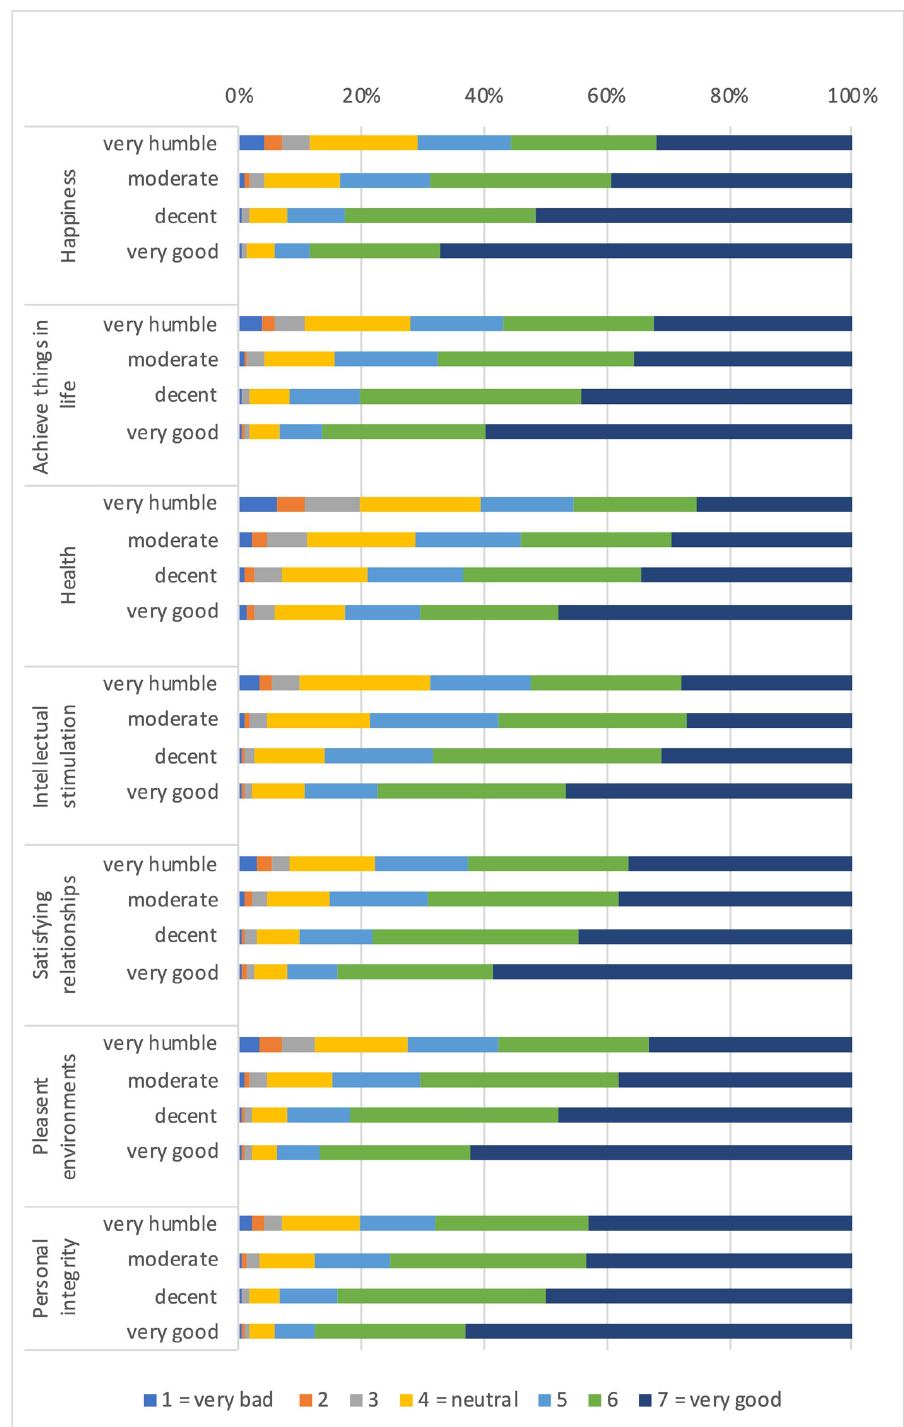
Figure 2. Distribution of capabilities and functionings according to economic capital (parental fi- nancial